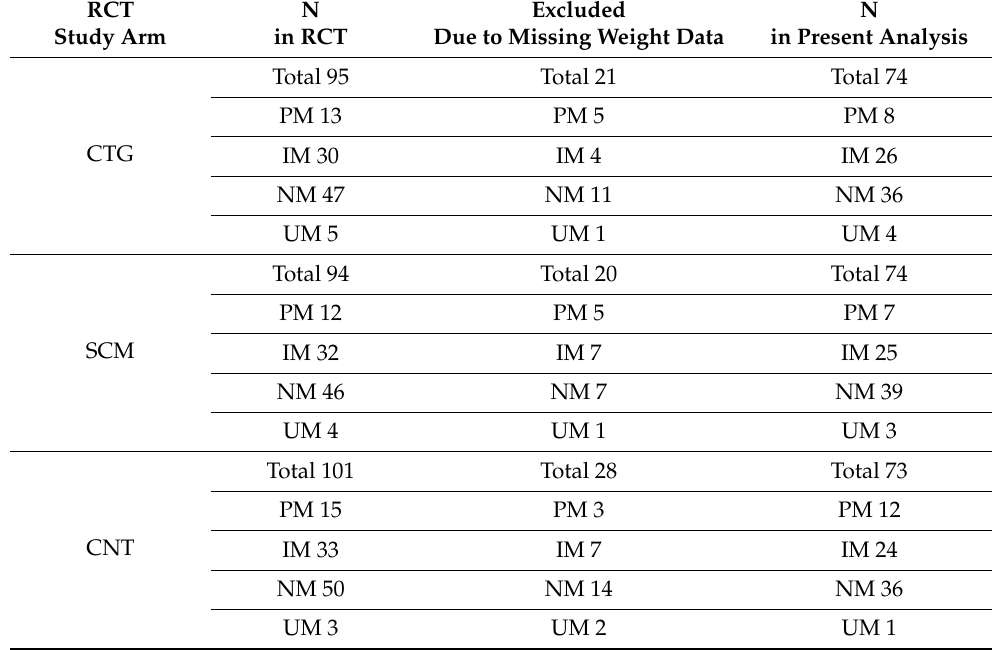
Table 1. Comparison of the number of patients and CYP2D6 metabolizer status included in the original RCT and the present